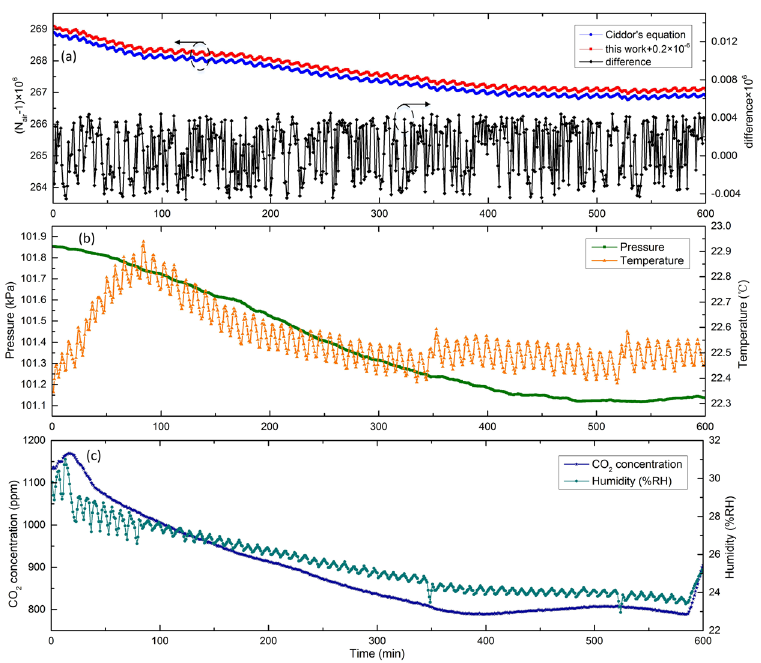
Figure 4. 10-h measurement of the group air refractive index. ( a ) Comparison between the measurement data and computed value from n p ( v ) + ( dn p ( v )/ dv ) v ( n p is obtained by the Ciddor’s equation). The arrow direction points out appropriate y axis. ( b ) Variations of pressure and temperature. ( c ) Variations of CO 2 concentration and